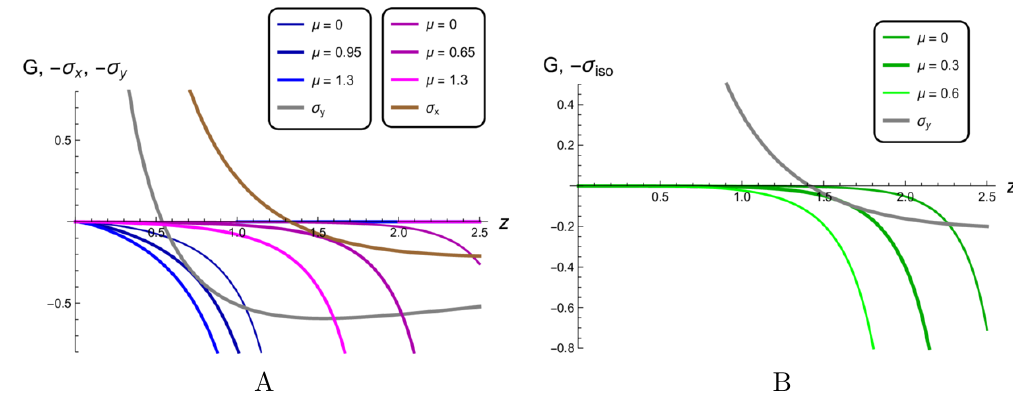
Figure 35 . The positions of the dynamical walls G = (cid:0) (cid:27) x for z h = 1 : 5 and G = (cid:0) (cid:27) y for z h = 3 in anisotropic (cid:23) = 4 : 5 (A) and isotropic G = (cid:0) (cid:27) iso ( z ) (B) cases, c = (cid:0)